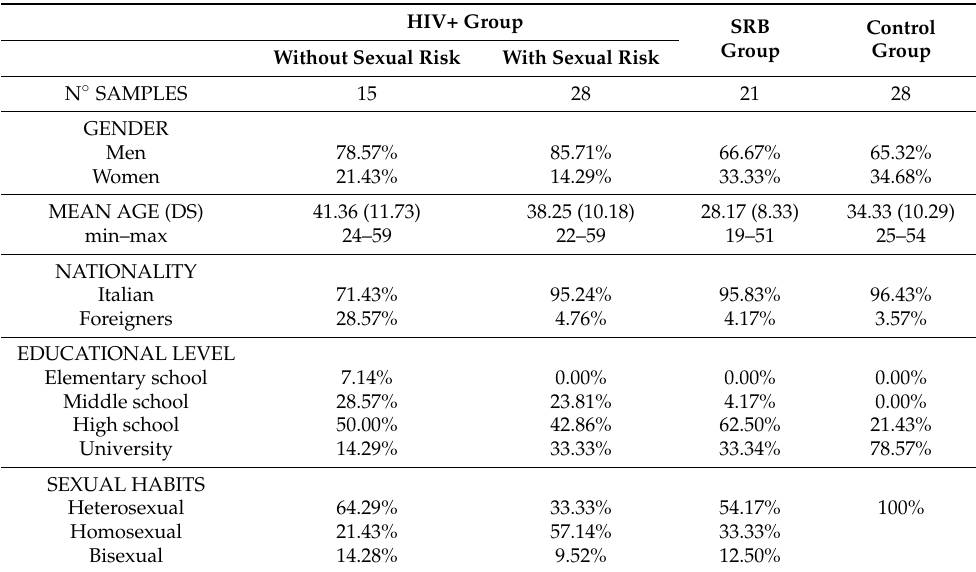
Table 1. Socio-demographic characteristics and sexual habits of the tested subjects. HIV+ Group SRB Group